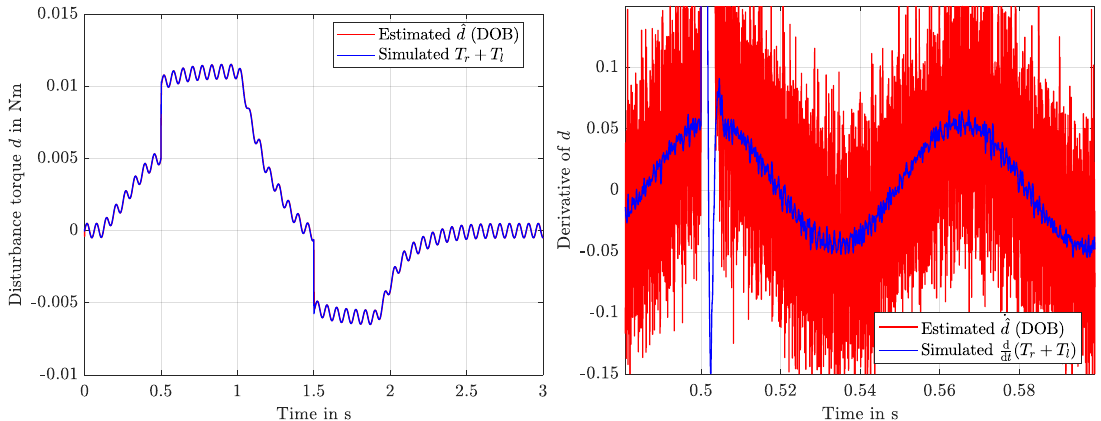
Figure 12. Disturbance estimates for d and ˙ d using disturbance observer